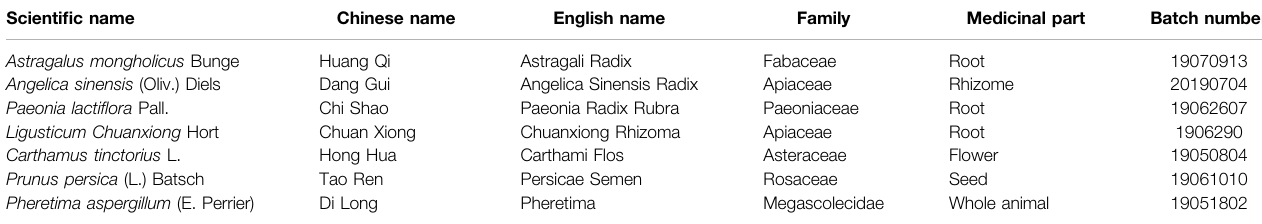
TABLE 1 | Components of the Buyang Huanwu